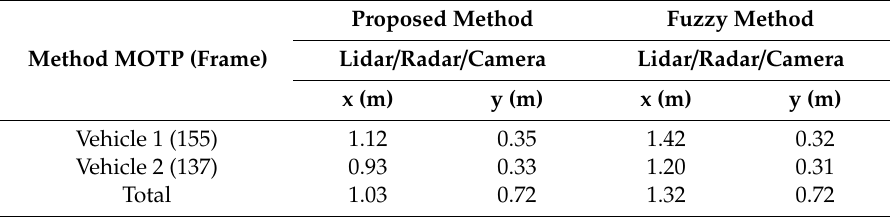
Table 6. Comparison of the results of the proposed method with fuzzy method in Scenario 3.